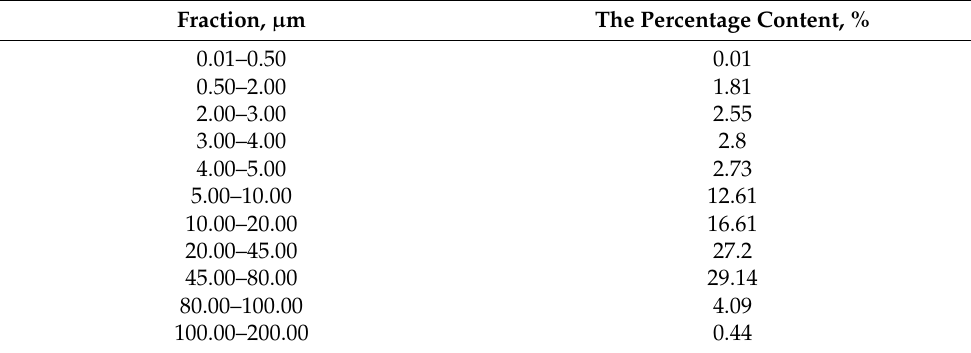
Table 6. Granulometric composition of the additive.